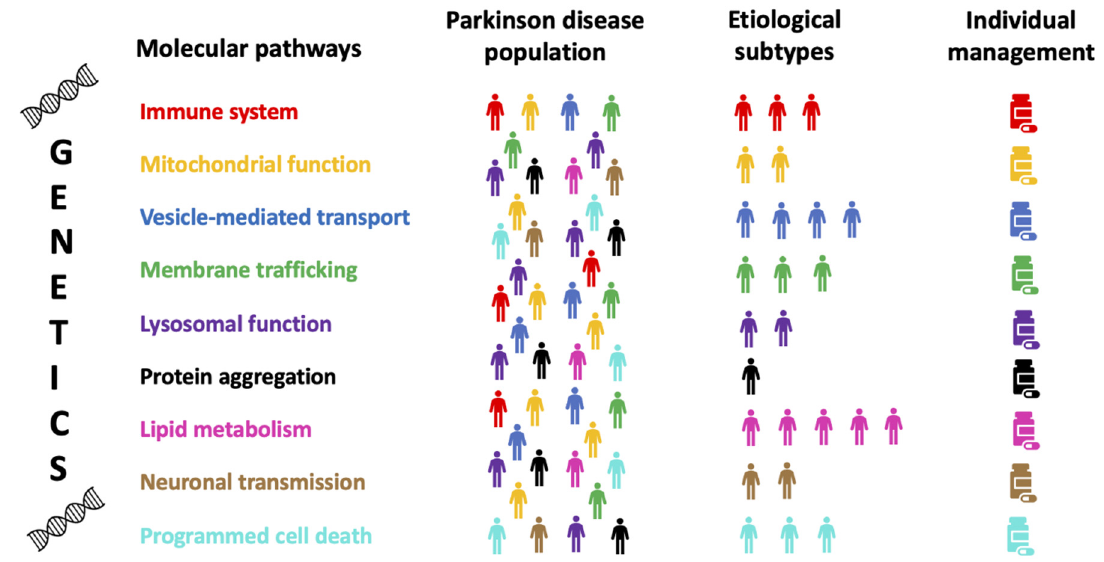
Figure 1. The role of genetics to define subtypes of Parkinson’s disease and to develop potential etiological based interventions. This figure serves as an example showing that certain molecular pathways within the same disease can be significantly enriched in different individuals. These pathways may eventually become targets for personalized based interventions.